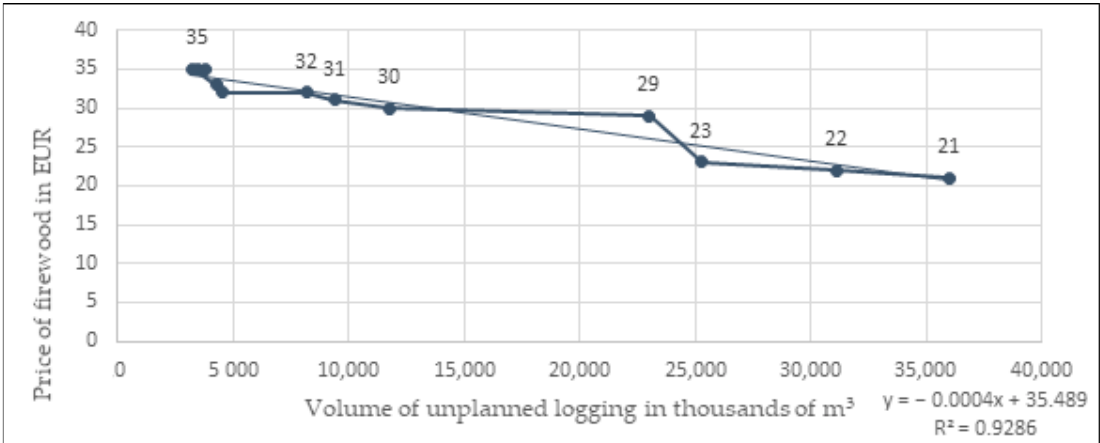
Figure 4. Dependence of the price of firewood on the volume of unplanned logging; Source: Č SU, (Czech Statistical Agency) 2020, Forestry.